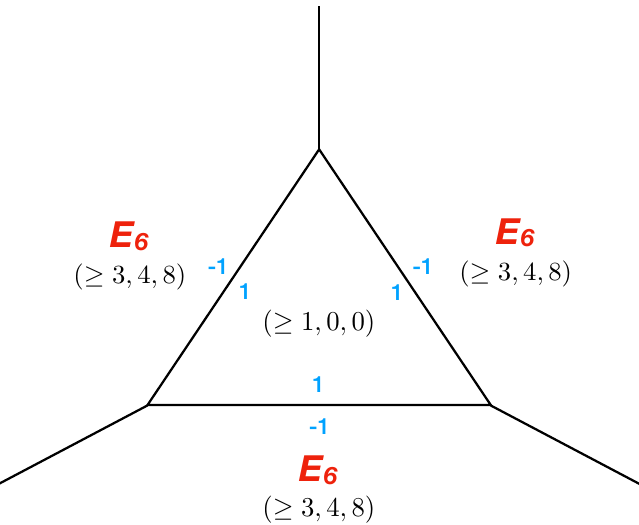
Figure 2 . The initally blown up E 6 { E 6 { E 6 Yukawa point.